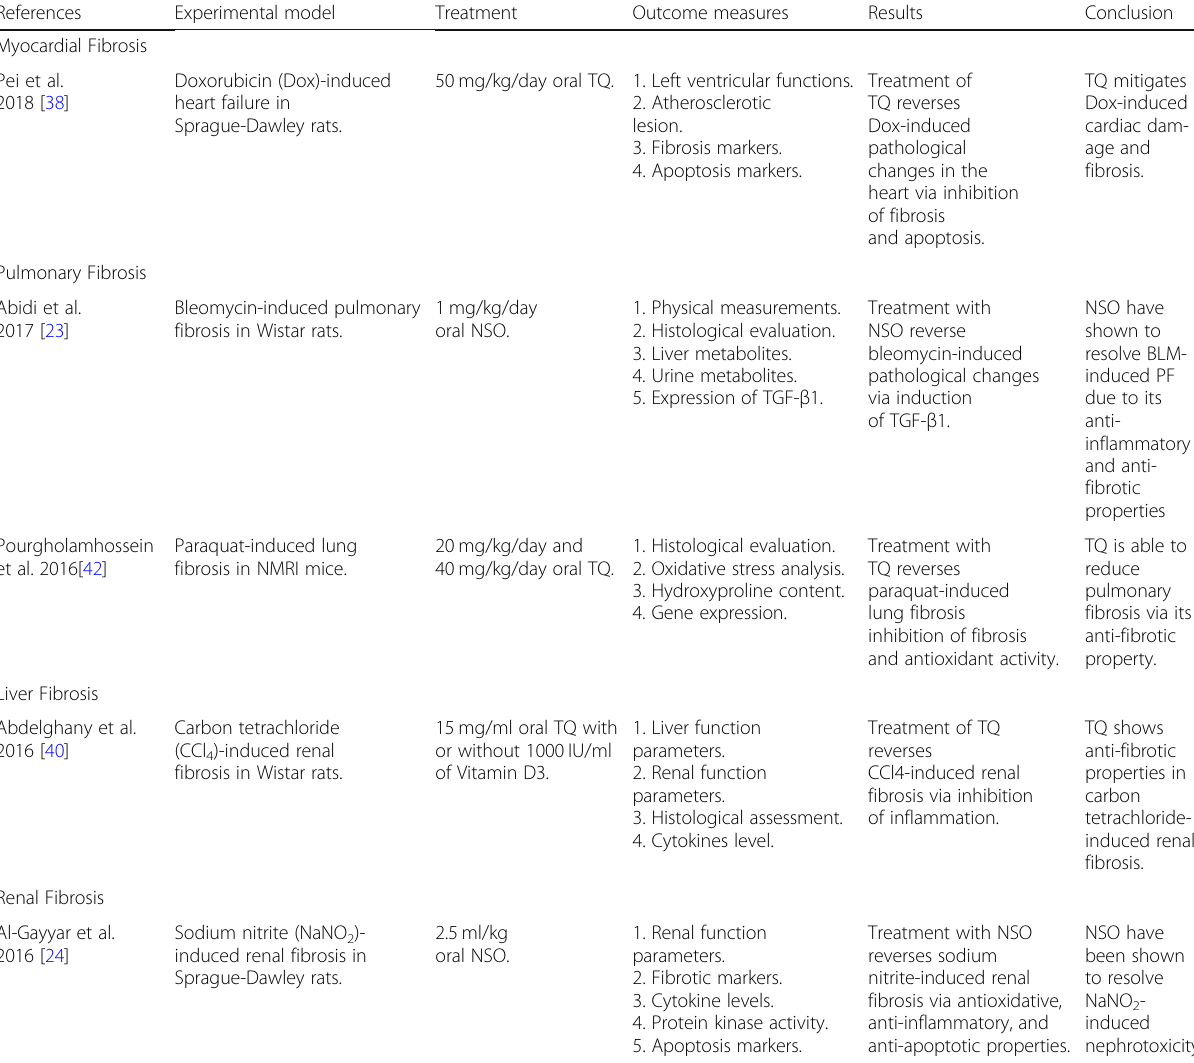
Table 2 Effect of Nigella sativa and thymoquinone on organ